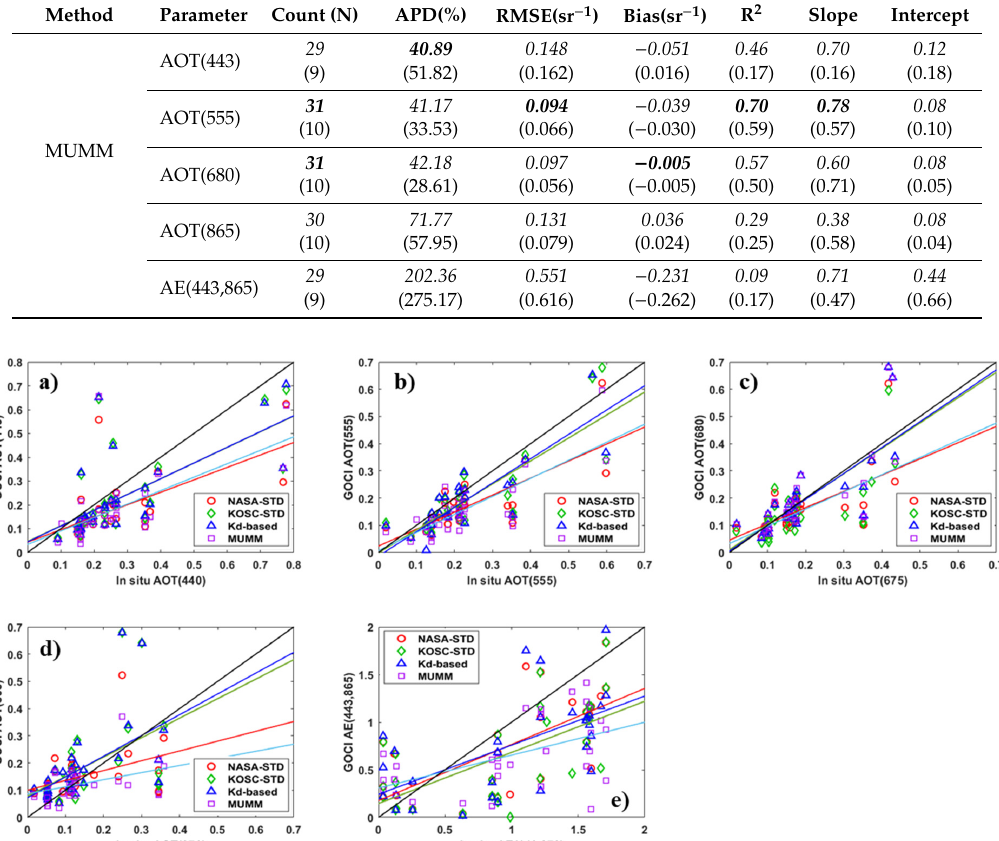
Figure 7. Scatterplots of GOCI-estimated ( a ) AOT(443), ( b ) AOT(555), ( c ) AOT(675), ( d ) AOT(865), and ( e ) AE(443,865) versus in situ aerosol products within a ± 3 h match-up time. Symbols are the same as described in Figure 4.